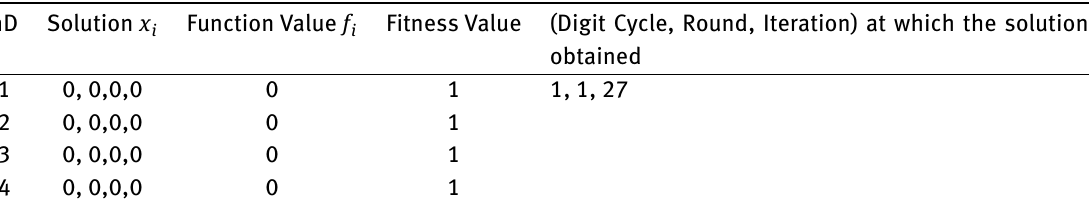
Table 10: Digit Cycle Results for Ackley’s function with 4 variables